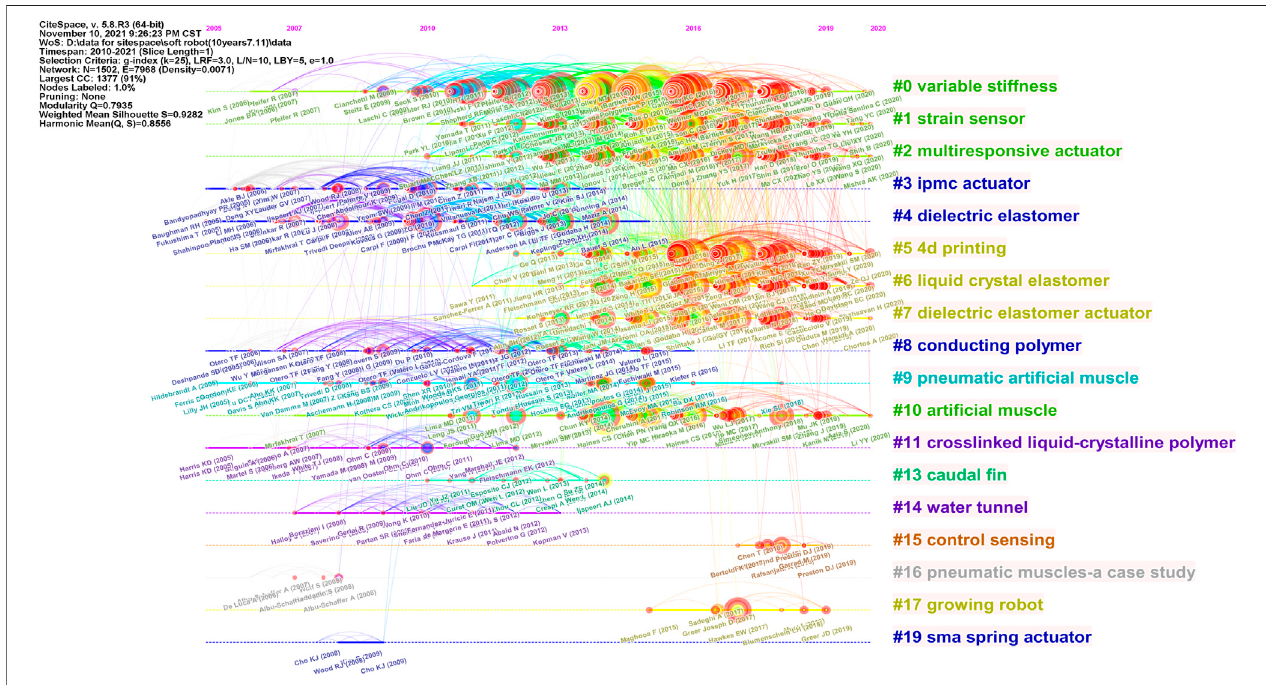
FIGURE 5 | Timelines of co-citation